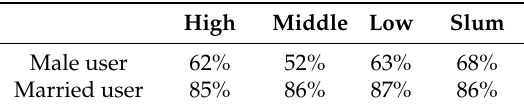
Table 2. Proportion of males and married